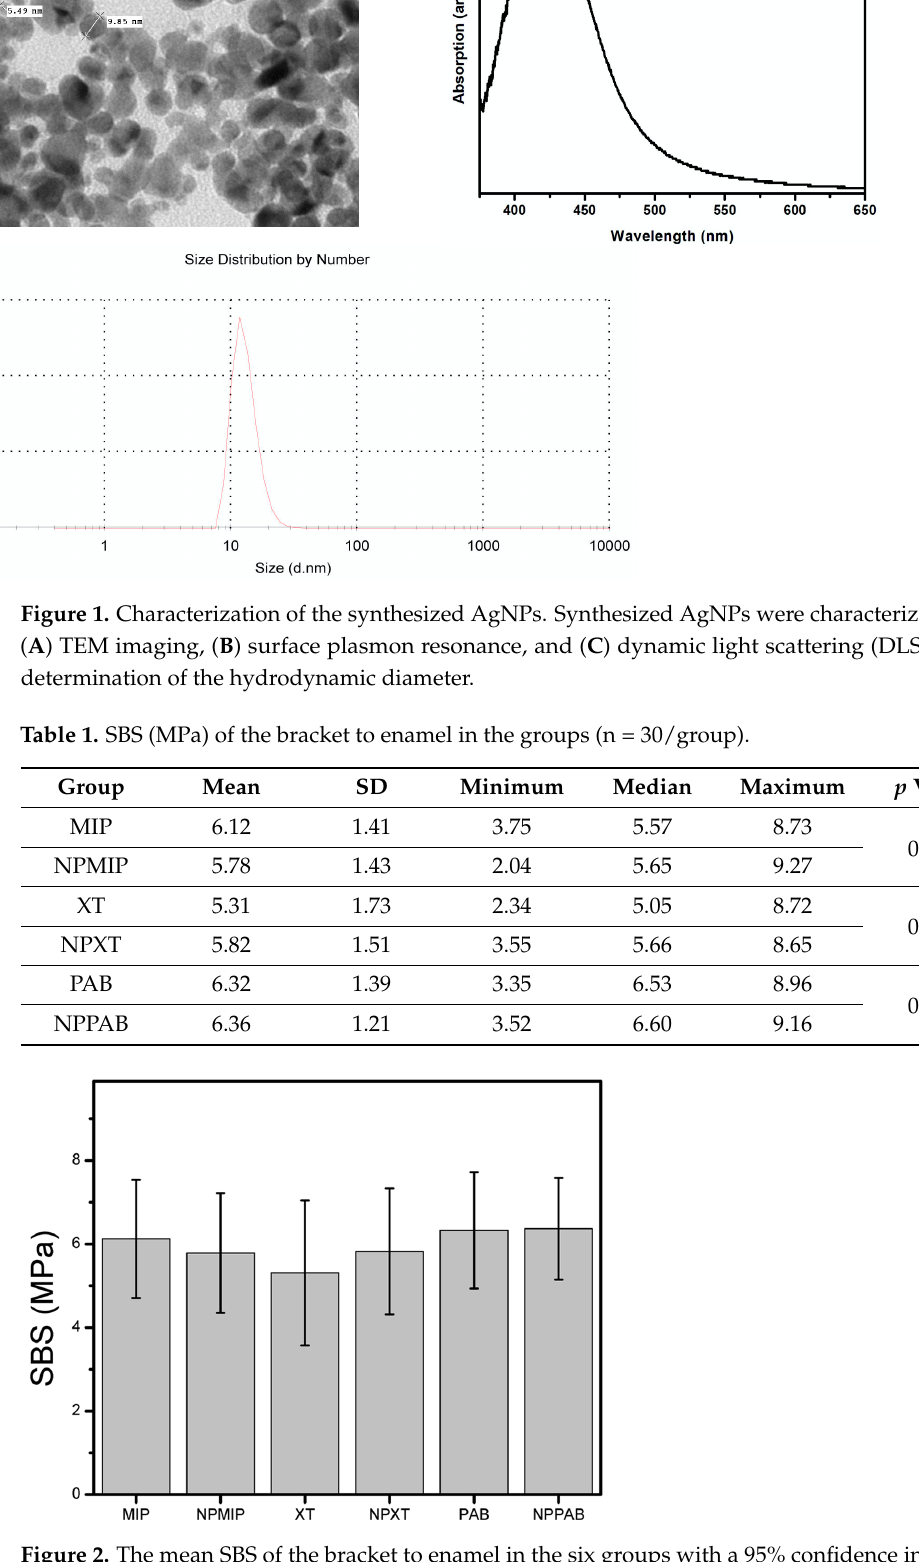
Figure 3. The frequency of adhesive remnant index (ARI) score number. Table 2. The frequency of adhesive failure (AF) scores, number, and percentage in the groups (n = 30/group).